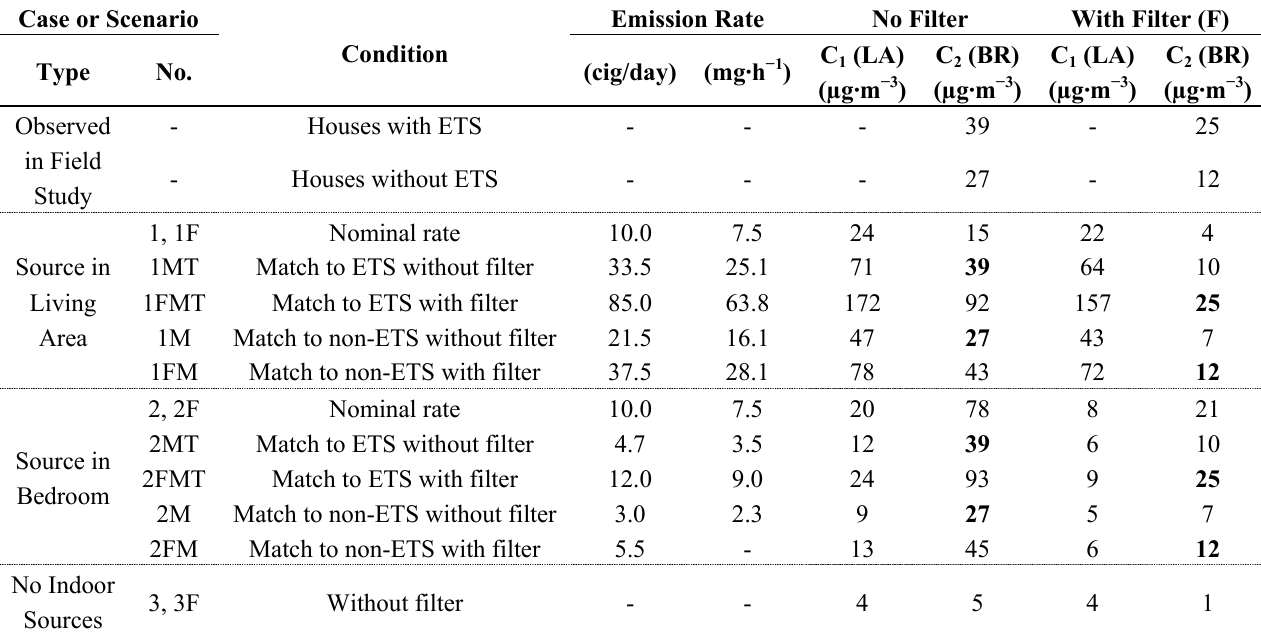
Table 5. Average concentrations observed in homes and results of scenario analyses, including adjustment of emission rates to match observed concentrations. C concentrations in living room (LA) and bedrooms (BR),